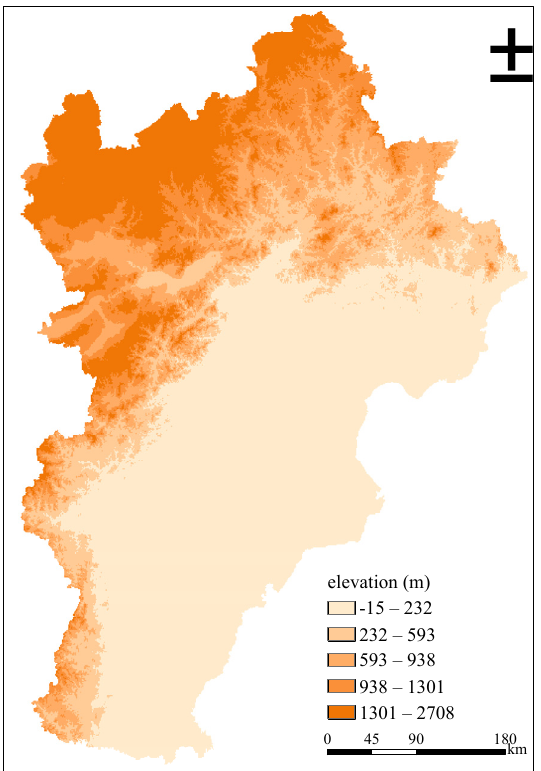
Figure 6. Elevation of Beijing–Tianjin–Hebei region.